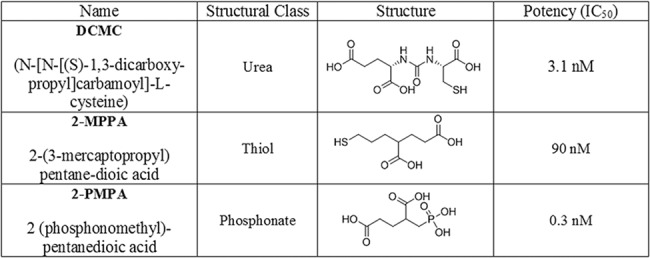
Chemical structures and IC50 values of DCMC, 2-MPPA, 2-PMPA.